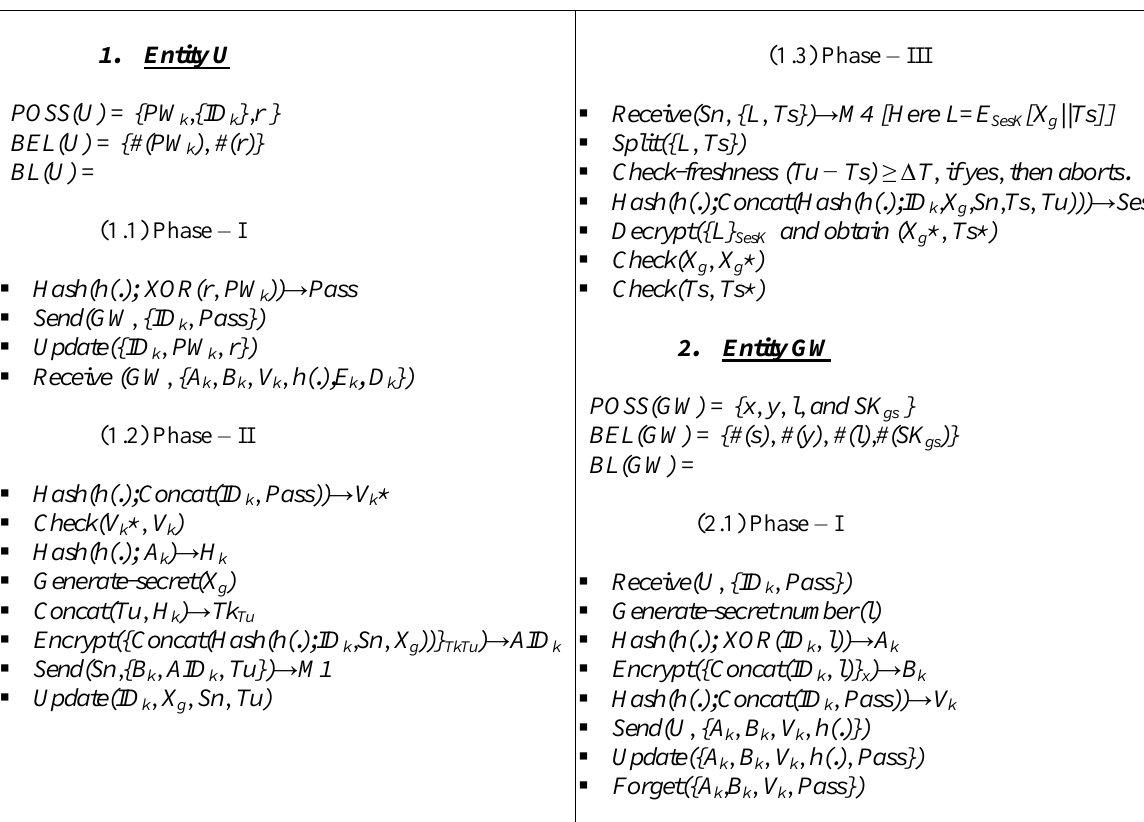
Table 3. Local Sets for